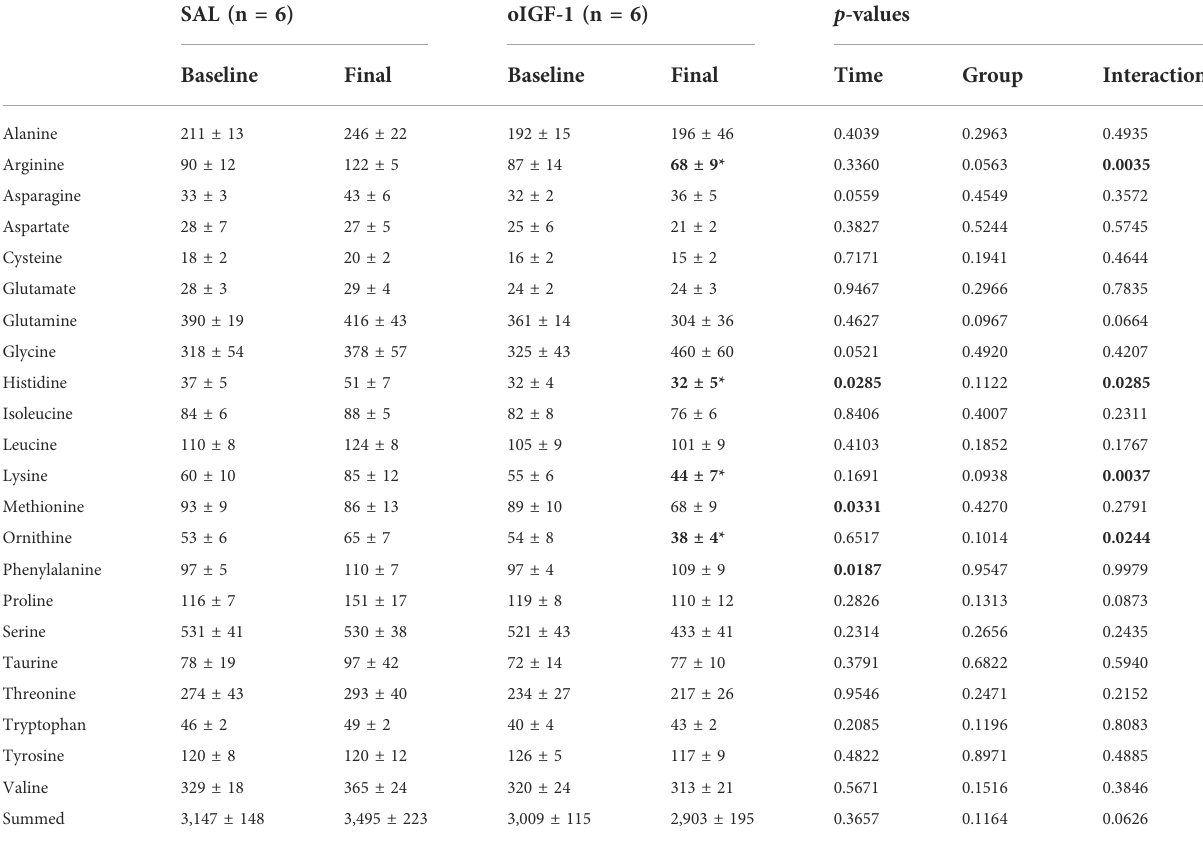
TABLE 4 Fetal concentrations of amino acids after 1-week infusion of oIGF-1 or saline